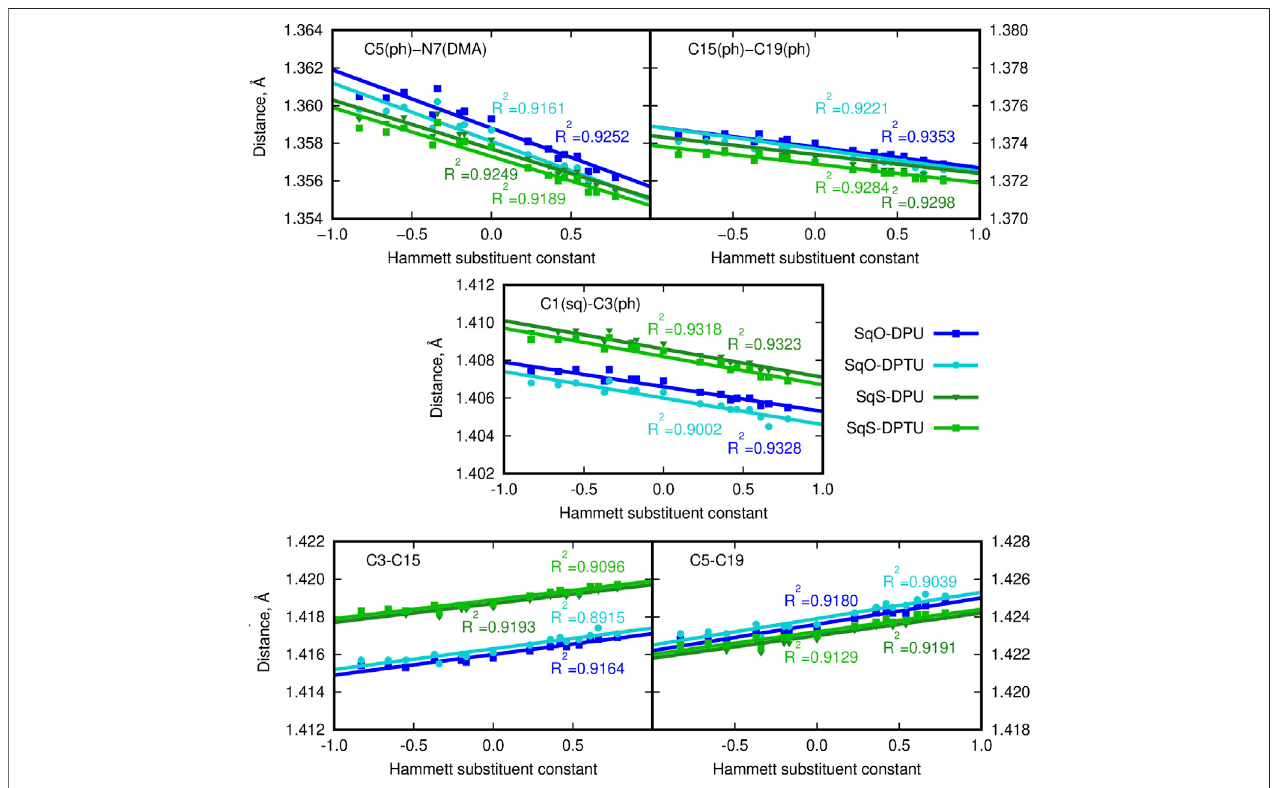
FIGURE2| Geometricalparametersforsquarainederivatives(atomnumberingin Figure1B ;hereandinthearticle;bluelines/pointsdenotetheoxygen-containing squaraine complexes and green lines/points, its thioderivative; while darker lines are used for urea and lighter for thiourea). (DMA) denotes the terminal dimethylamino group and (ph) stands for the phenyl ring in (thio)squaraine.